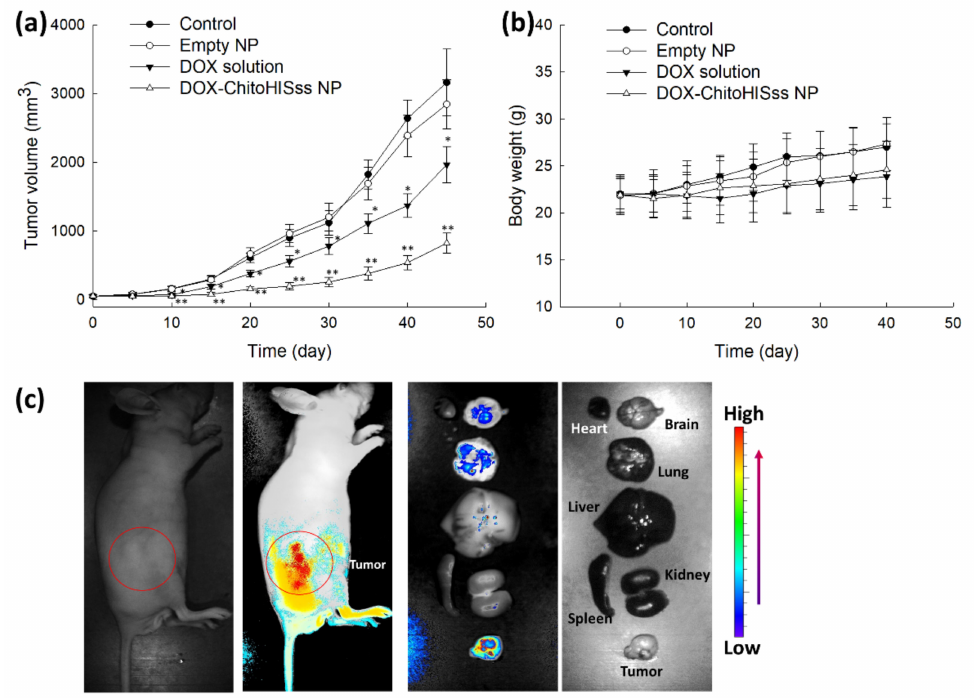
Figure 10. Antitumor activity of DOX-incorporated ChitoHISss nanoparticles. ( a ) Tumor growth; ( b ) body weight changes. The tumor xenograft model of DOX-resistant HuCC-T1 cells was prepared in the back of nude BALb/C mice. DOX-incorporated nanoparticles were i.v. administered through the tail vein (injection volume: 100 µ L; dose, 10 mg/kg as a DOX concentration). The treatment dose as a DOX was adjusted to 10 mg/kg. All results are expressed as average ± S.D. from five mice. ( c ) Fluorescence imaging of the tumor-xenograft model of DOX-resistant HuCC-T1 cells. For the fluorescence image, Ce6-incorporated ChitoHISss nanoparticles were i.v. administered via the tail vein of the mouse (10 mg/kg as a Ce6 concentration). The injection volume was 100 µ L. One day later, the mice were sacrificed for observation of each organ. Empty NP: empty nanoparticle; DOX-ChitoHISss NP: DOX-incorporated nanoparticles. * indicates comparison between control and DOX solution; ** indicates comparison between control and DOX-ChitoHISss NP. ANOVA followed by Tukey test, p <